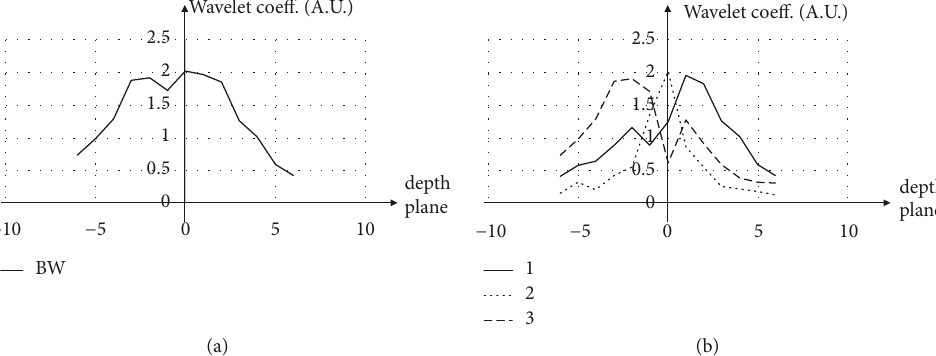
Figure 2: Waveletcoefficientsof binary BW image Figure1: (a) whole image, (b) each digit separately.(The depth plane is an integernumber.)